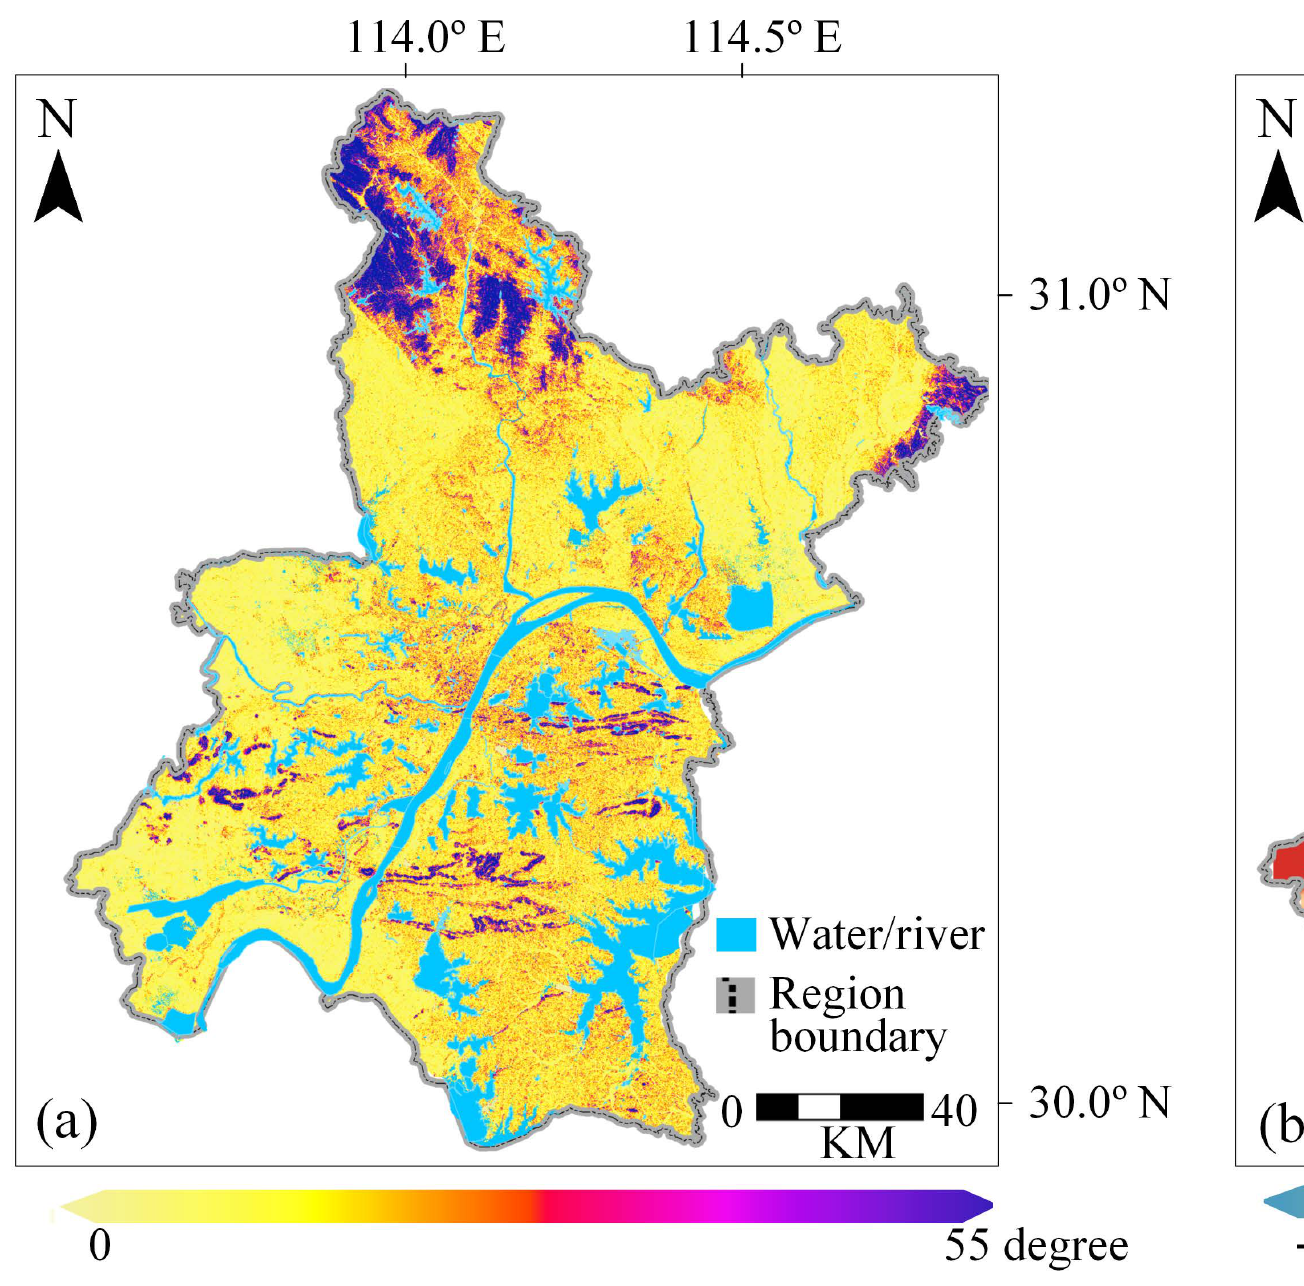
Figure 6. Slope map ( a ) and the coe ffi cient for percentage of landscape (PLAND, ( b ) and aggregation index (AI, ( c )) from geographically weighted regression